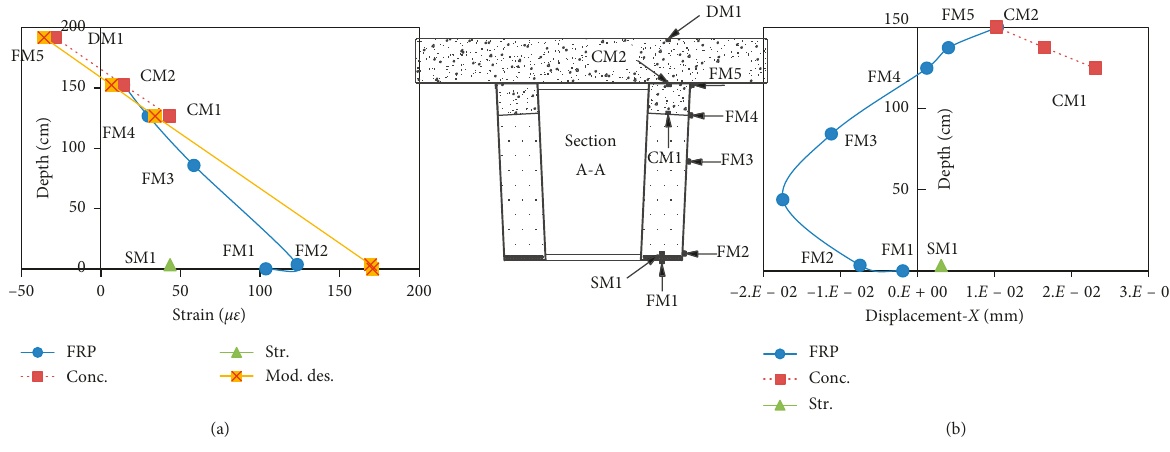
Figure 9: (a) Strain profile. (b) Displacement in X -dir. due to stop 1 section